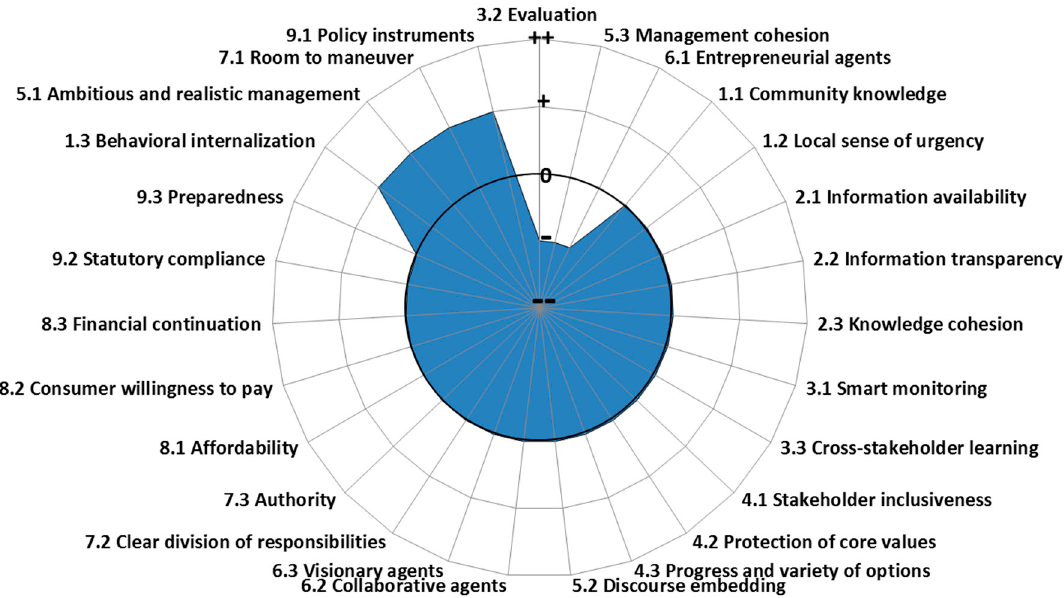
Figure 2. Results of the governance capacity to alleviate water stress by wastewater-reuse schemes in the city of Sabadell, Spain. The 27 indicators are organized clockwise around the spider web circle by most limiting ( −− ) to most encouraging (++).